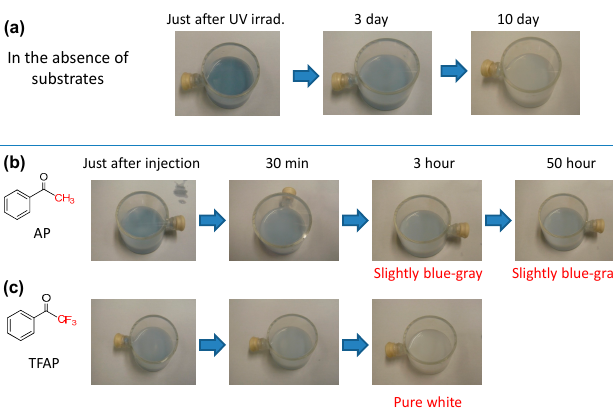
Figure 3. Color changes of the pre-irradiated P25 TiO 2 powder dispersed in de-aerated ethanol ( a ) in the absence of substrates, and after injection of ( b ) 300 µ mol acetophenone (AP), or ( c ) 2,2,2-trifluoacetophenone (TFAP). Adapted with permission from reference [63]. Copyright 2012 American Chemical Society. UV irrad.: UV irraditaion.